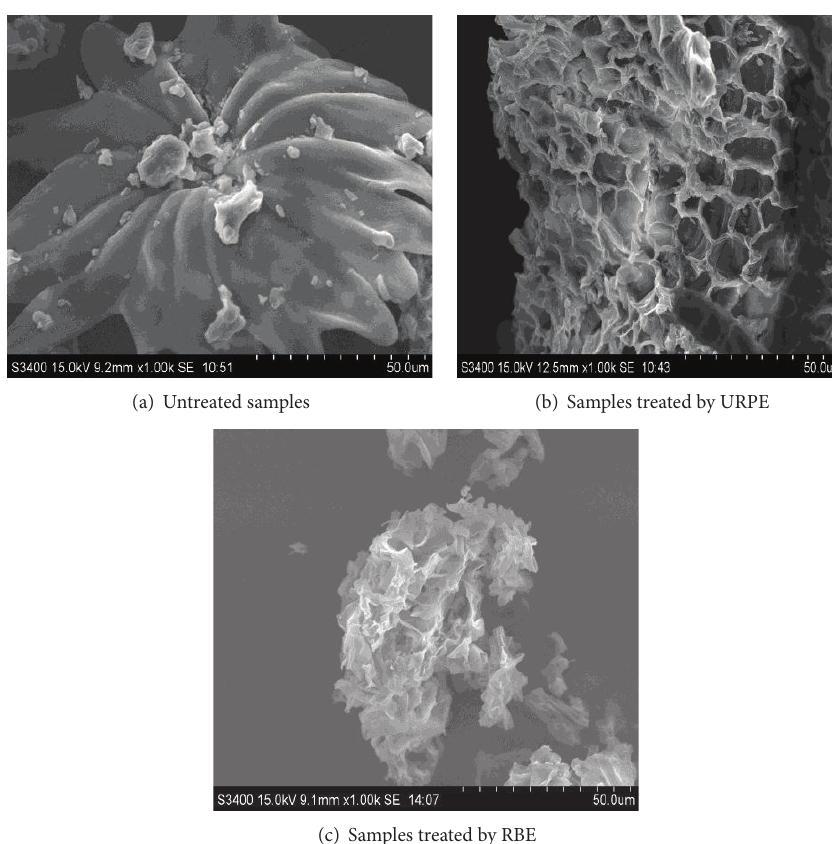
Figure 3: Displaying samples after being treated by URPE and RBE, compared with untreated